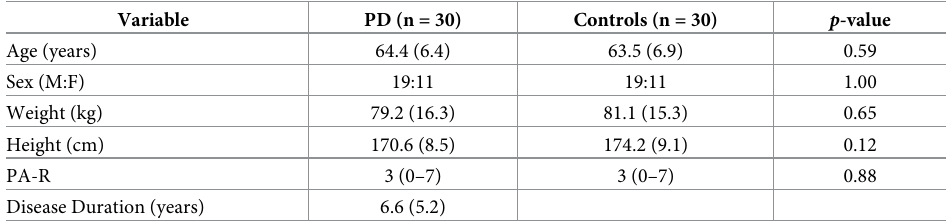
Table 1. Descriptive statistics of participants with Parkinson’s Disease (PD) and